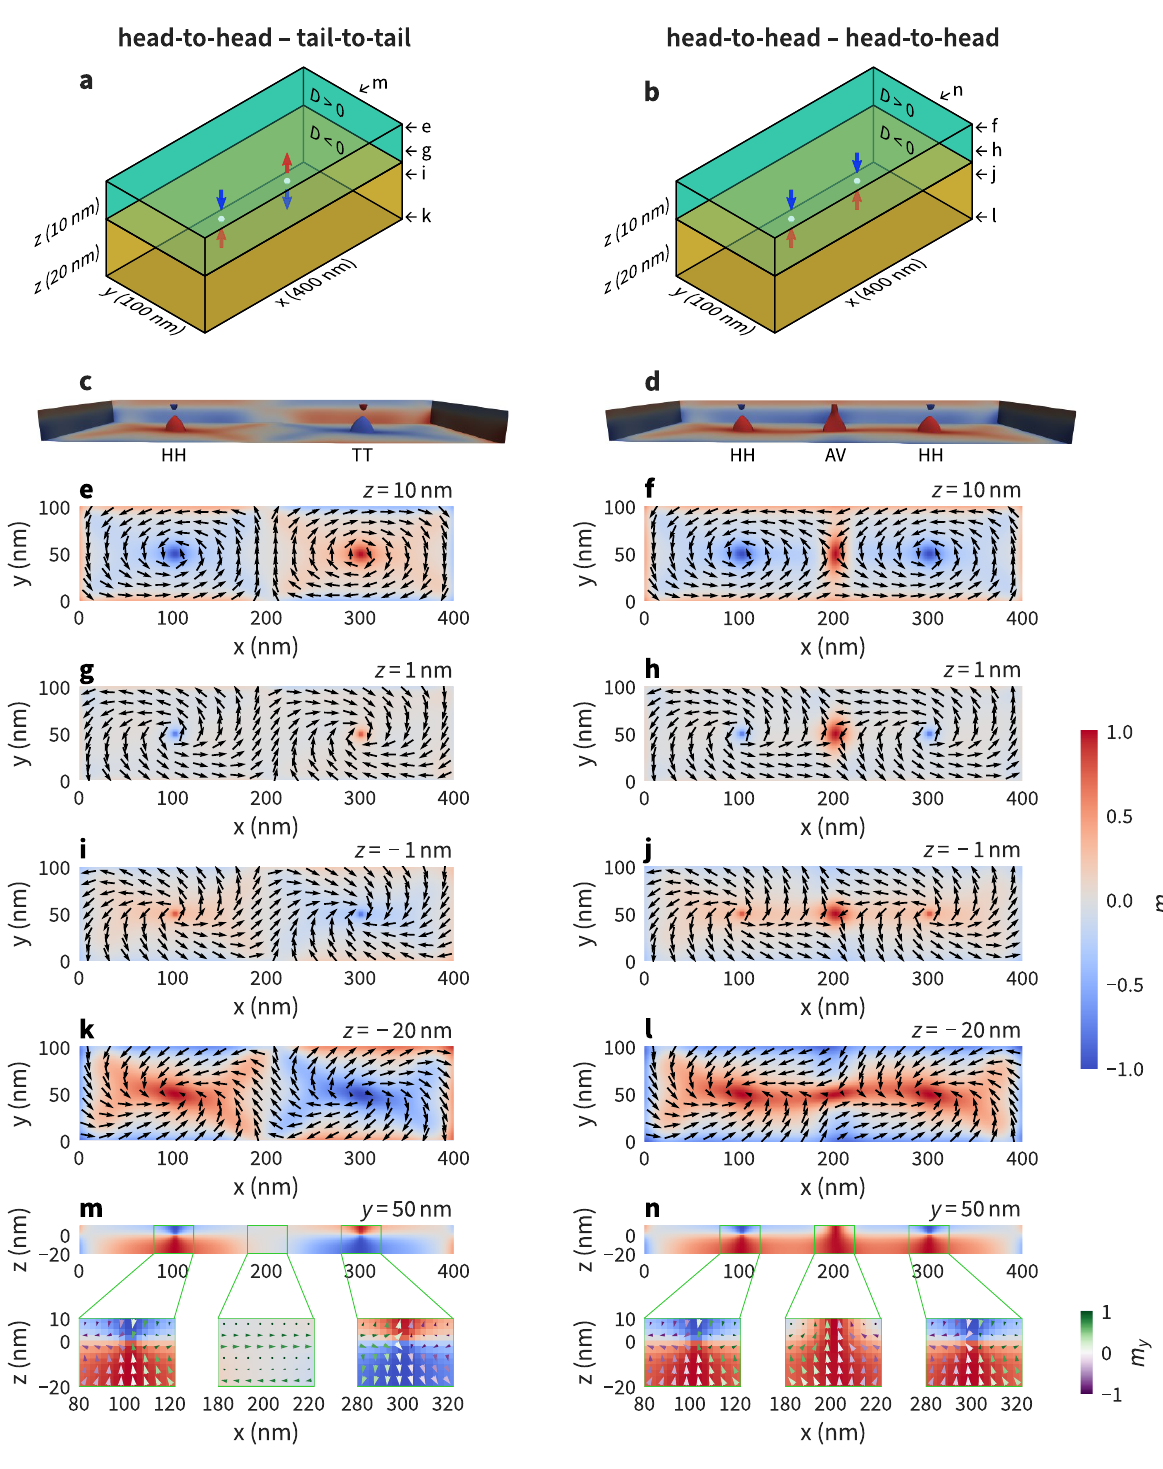
Figure 2. Magnetisation profile of the two fundamentally different configurations containing two Bloch points: opposite-type Bloch points (head-to-head and tail-to-tail, left column) and same-type Bloch points (head-to- head and head-to-head, right column). The 3D renderings in ( c ) and ( d ) show isosurfaces for m z = ± 0.9 , colour indicates the z component. Several different cut planes in xy and xz are shown to reveal the three-dimensional structure of the Bloch points forming at the interface ( z = 0nm ). For the xz plane (subfigures m and n ) we also show enlarged plots around the Bloch point and antivortex position. The cones in ( m ) and ( n ) are coloured according to their m y component, as indicated by the small colour bar in the right bottom corner of the